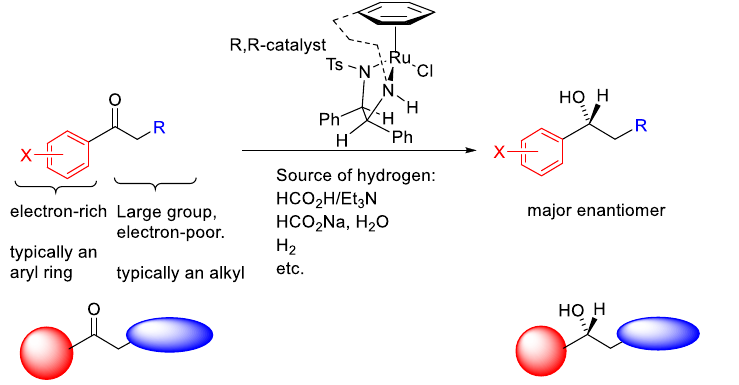
Figure 4. Summary of stereocontrol features in ATH using Noyori – Ikariya catalysts.